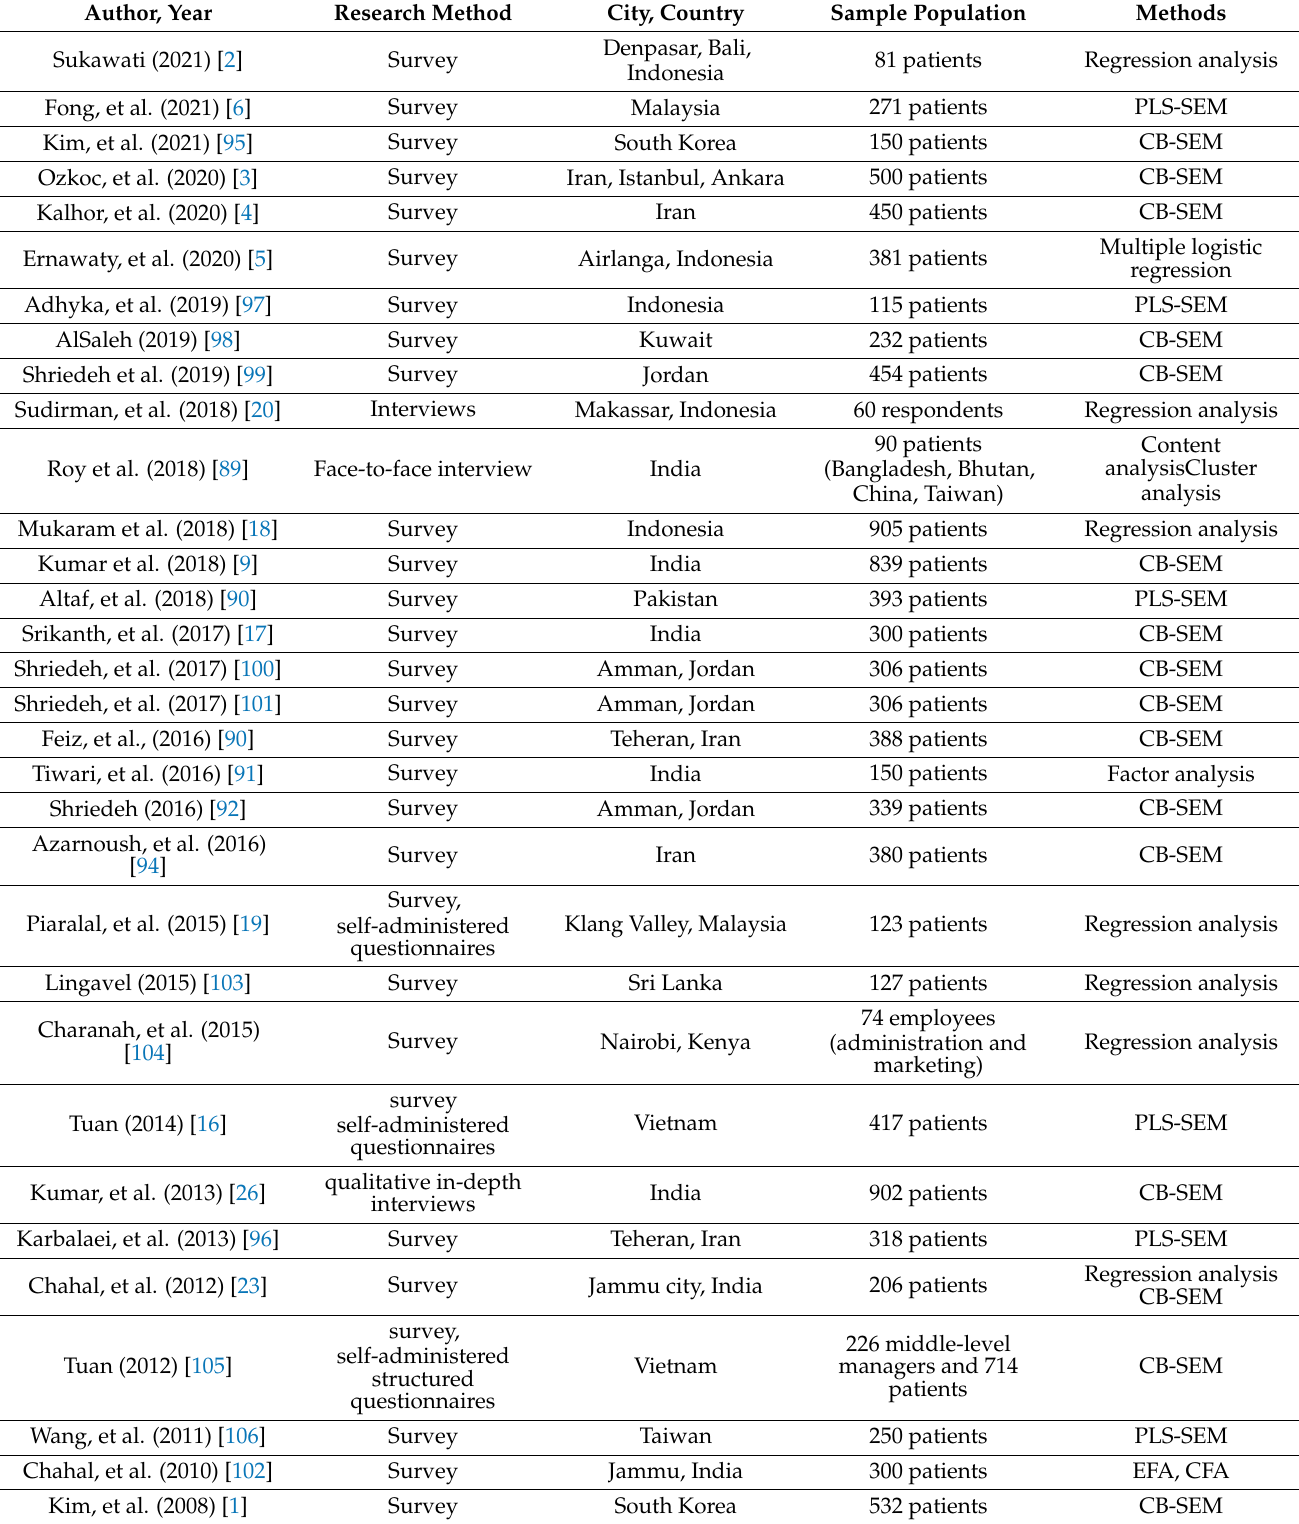
Table 1. General details of studies included in the systematic